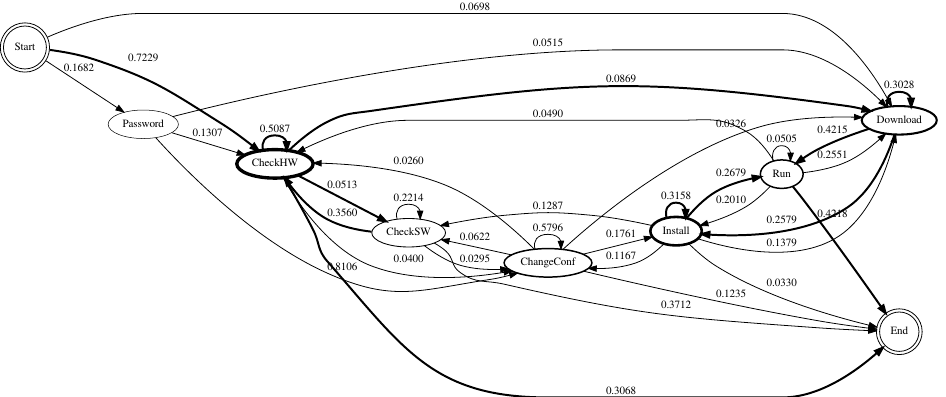
Figure 6. State diagram of the attacker’s behaviour on Midgard.